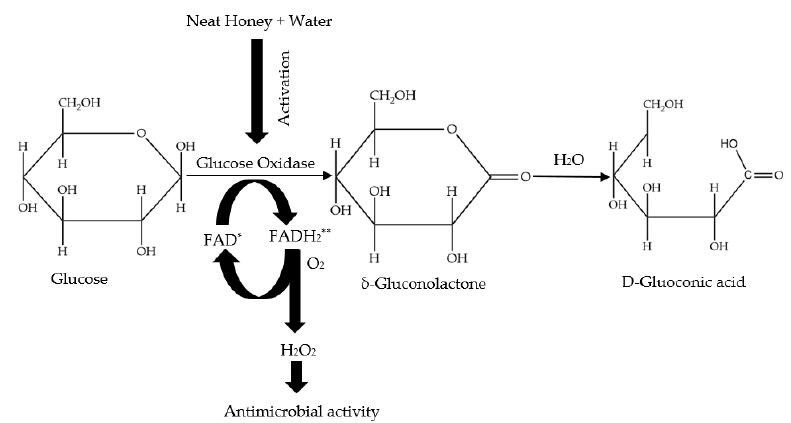
Figure 2. Generation of hydrogen peroxide through the calalyzed reaction by glucose oxidase.